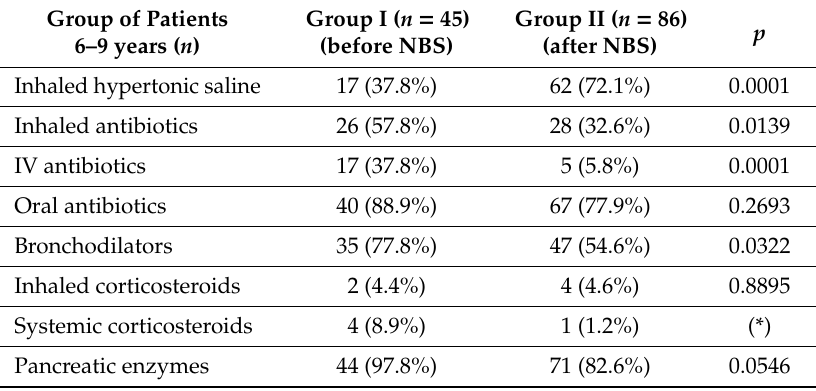
Table 4. Use of di ff erent treatment regimes and medicaments in the Groups I and